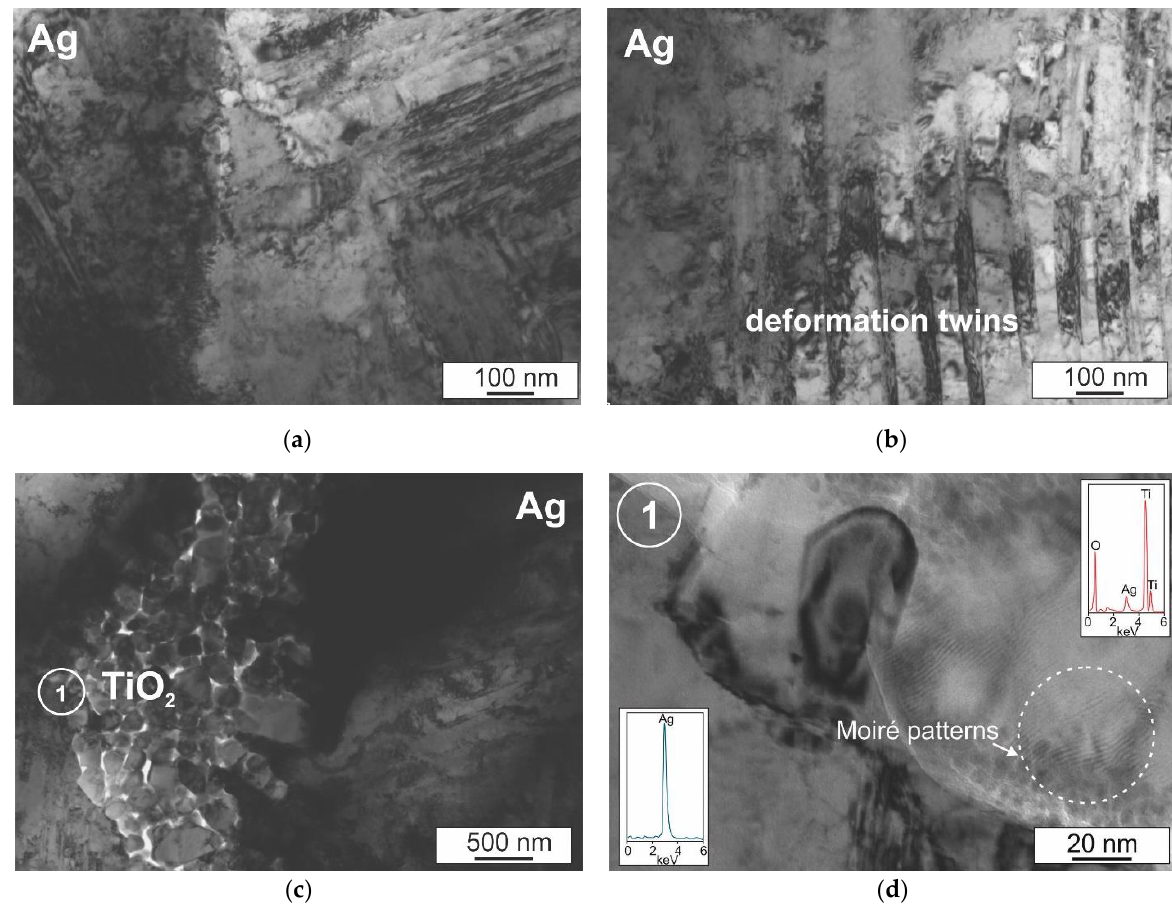
Figure 7. XRD analysis of Ag–5wt% TiO 2 composites; ( a ) in range of intensity 0–2500; ( b ) in range of intensity 0–500.